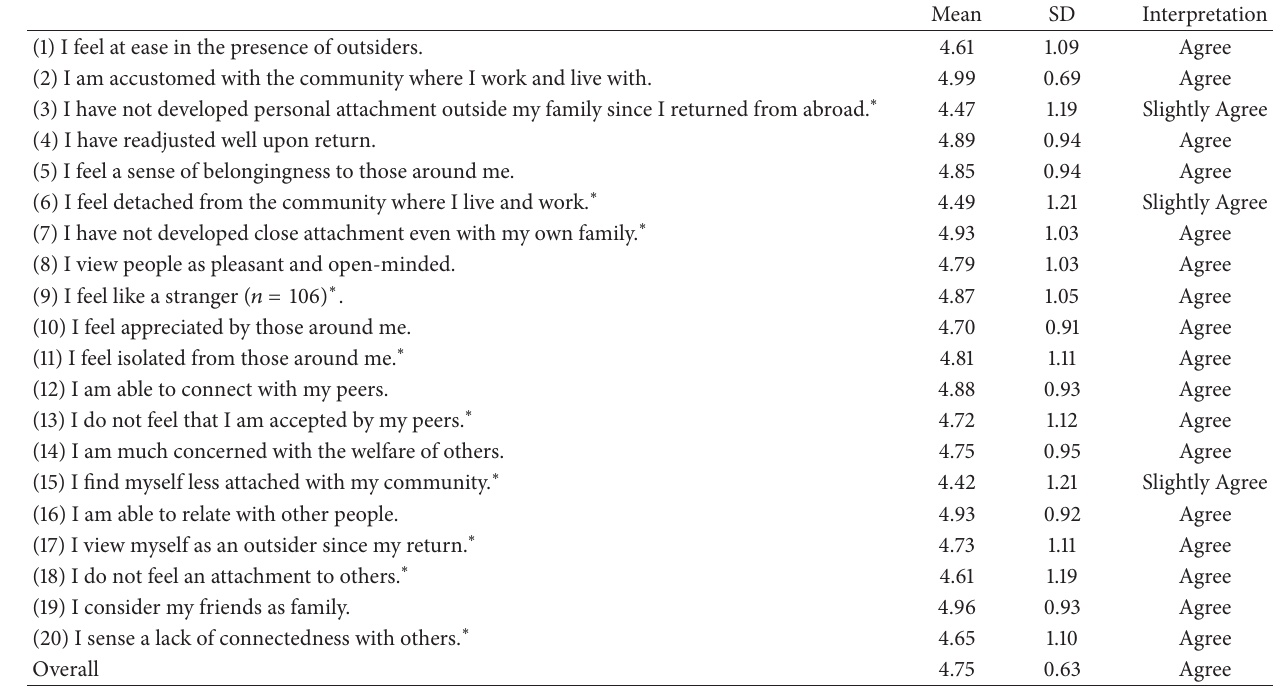
Table 2: Mean scores of respondents’ social connectedness ( 𝑛 = 107 ).